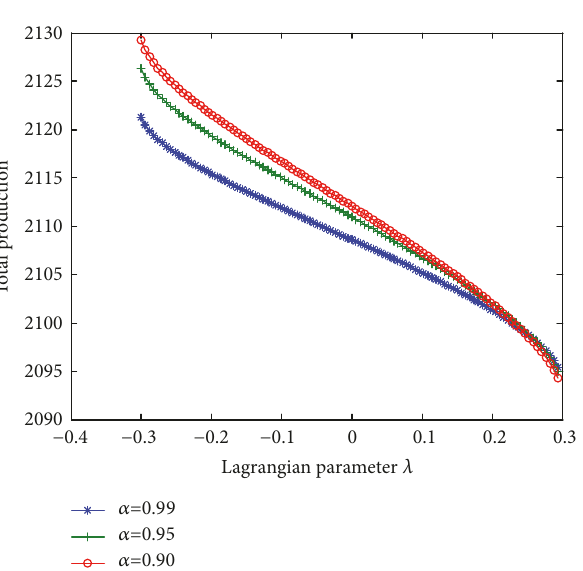
Figure 9: Total production amount under different 𝜆